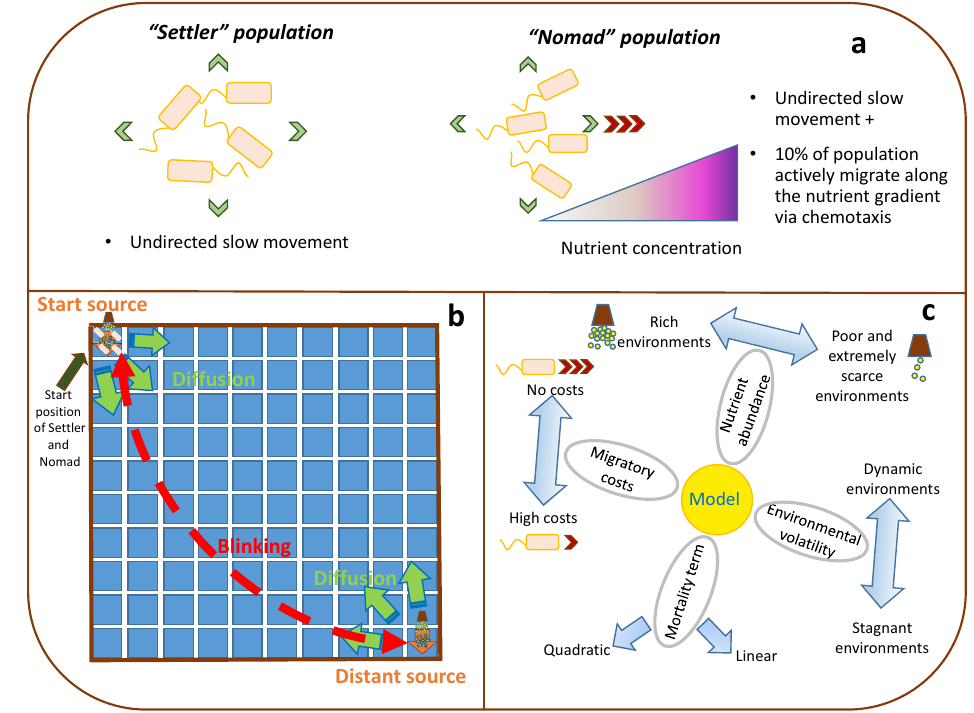
Figure 1. Conceptual diagram of two population strategies ( a ), the habitat structure ( b ) and simulation scenarios ( c